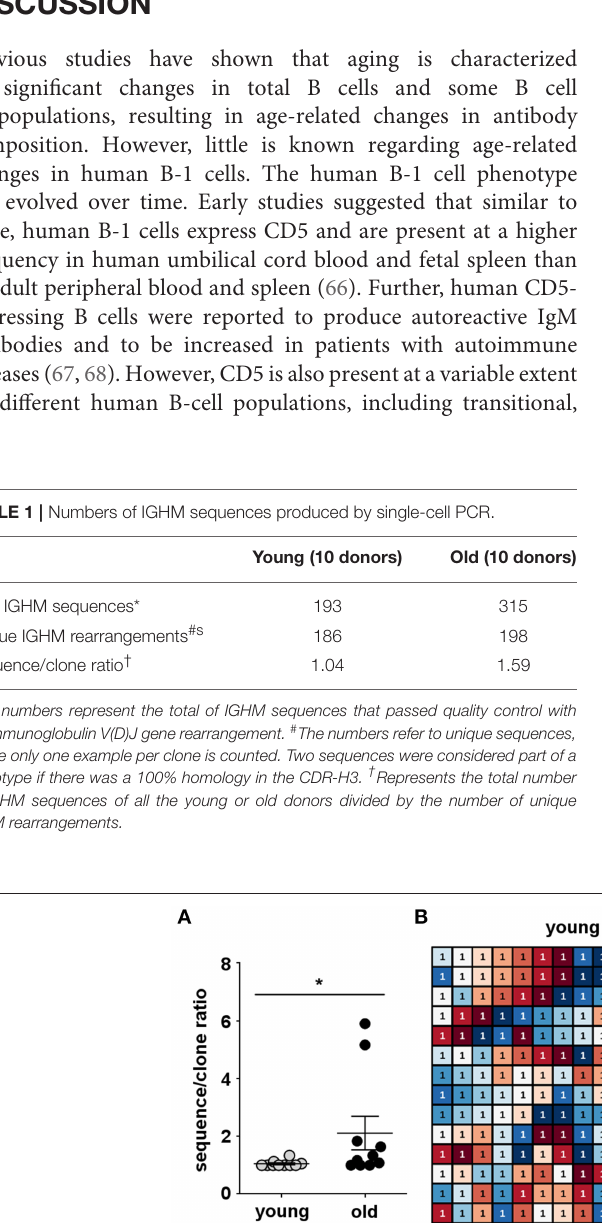
Frontiers in Immunology |